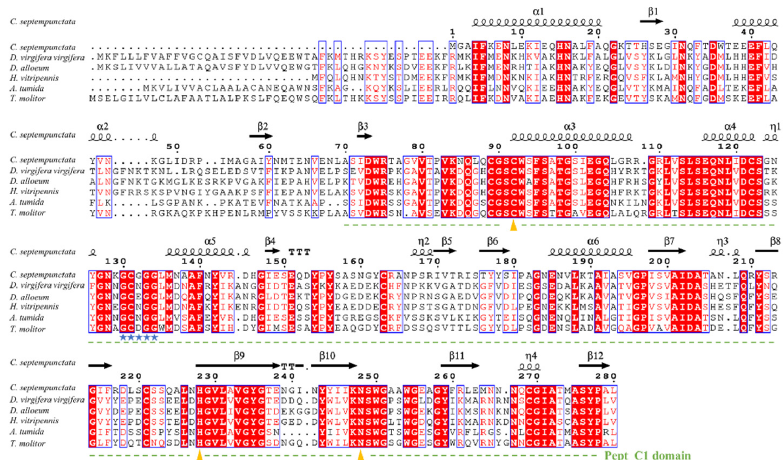
Figure 1. Multiple-sequence alignment of C. septempunctata CatL with the corresponding proteins from other insect species. Alpha-helices, eta-helices, beta strands, and beta turns are marked by α , η , β and TT, respectively. The conserved Pept_C1 domain is underlined. The active sites of Cys139-His278-Asn299 and the domain containing the “GCXGG” motif are labeled with yellow triangles and blue stars, respectively. GenBank accession numbers are: Coccinella septempunctata (this study), Diabrotica virgifera virgifera (XP_028133575.1), Diachasma alloeum (XP_015123049.1), Homalodisca vitripennis (KAG8293399.1), Aethina tumida (XP_019868286.1), and Tenebrio molitor (AAR05023.1).